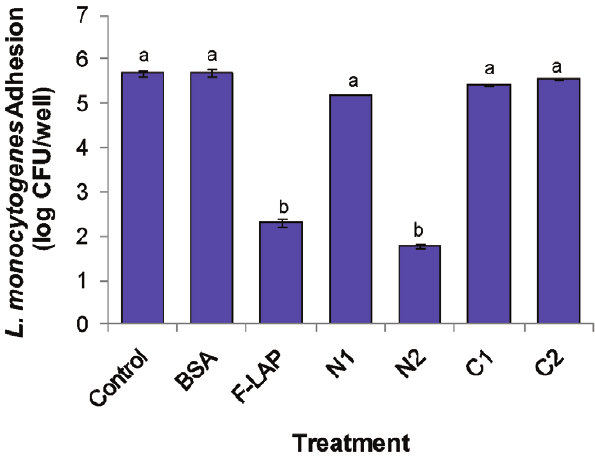
Figure 5. Adhesion analysis of Listeriamonocytogenes cells to HCT-8 epithelial cells pretreated with LAP subdomain proteins (40 m g/well). N2 and F-LAP showed significant reduction (about 3- 4 log cfu/ml) in L. monocytogenes adhesion to HCT-8 monolayers than the other treatments including BSA, N1, C1, C2 and untreated control. Bars marked with letters (a,b) are significantly different at P ,